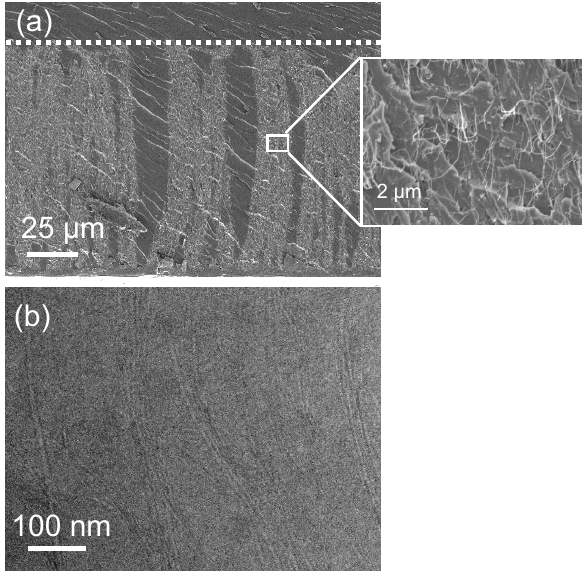
Figure 13. Images of a CNT forest after infiltrating with epoxy (a) SEM image of a liquid nitrogen fractured cross-section. The CNTs are compacted slightly into columns (bright regions) due to surface tension effects, leaving CNT free regions (dark) in between. (b) TEM image (sample prepared by focus ion beam milling). The contrast between the CNTs and epoxy is low due to their similar carbon based